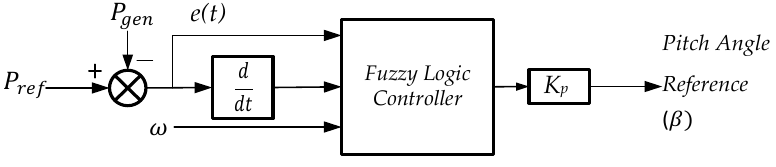
Figure 4. Control System Block Diagram.